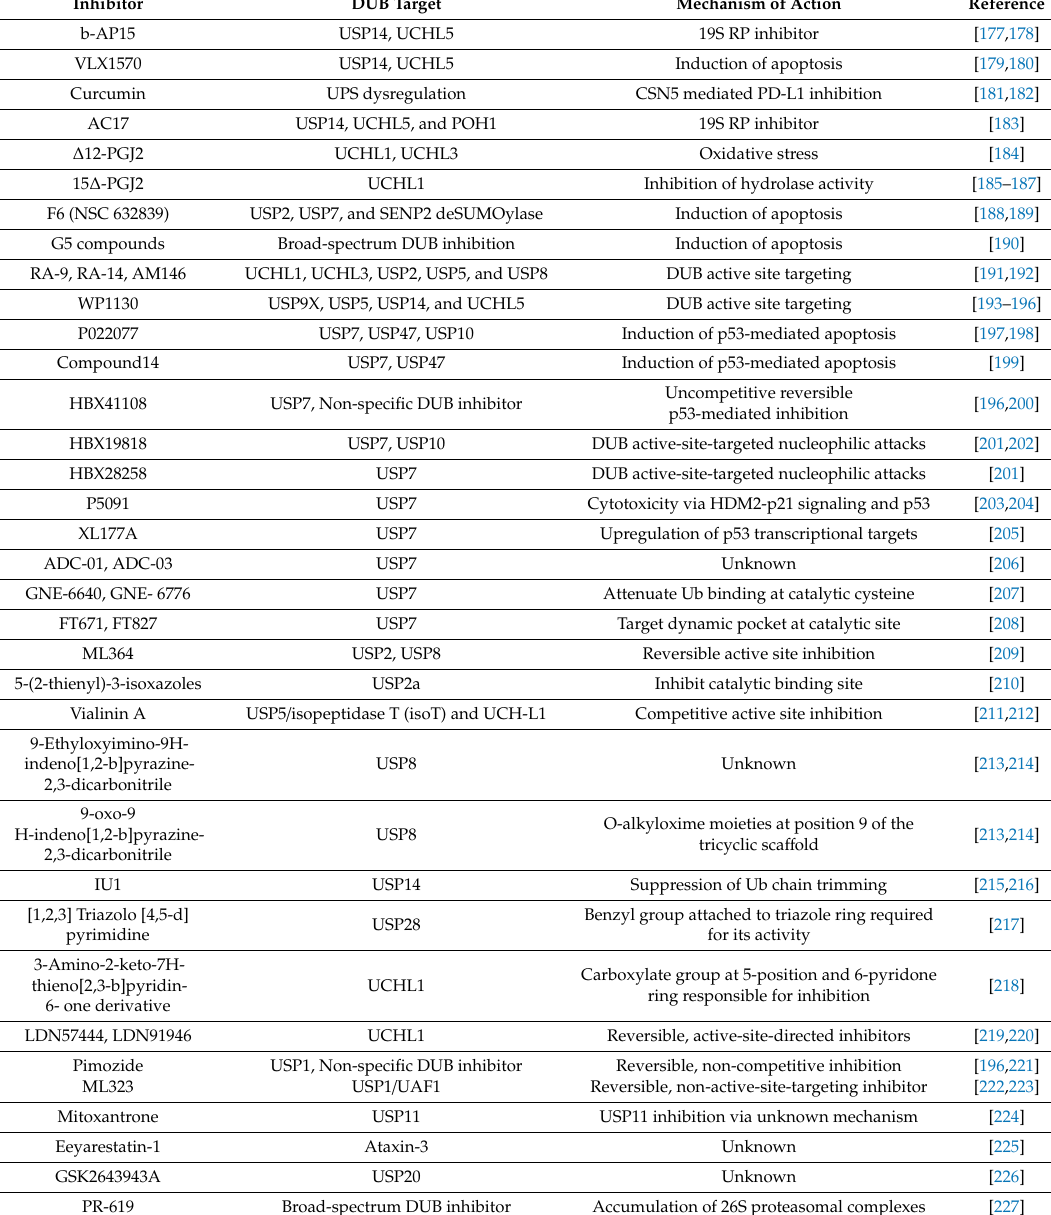
Table 1. Summary of DUB inhibitors in